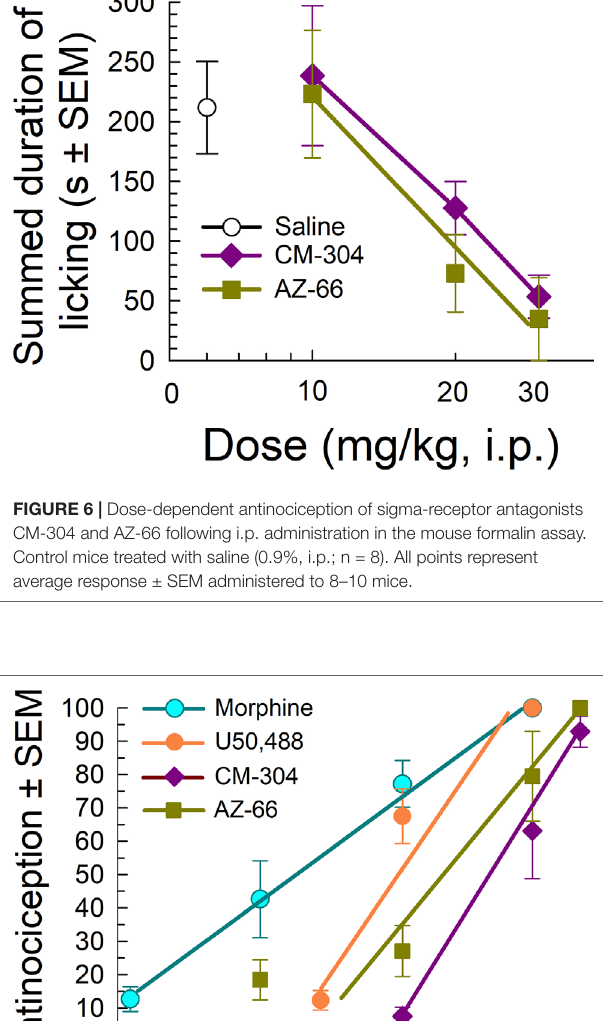
FIGURE 8 | Dose- and time-dependent (A) respiratory depression and (B) spontaneous locomotor effects of morphine (cyan circles) or U50,488 (orange hexagons) evaluated in the CLAMS assay with C57BL6/J mice. * = significantly greater than vehicle effect (dashed line), p < 0.05; two-way ANOVA w/Dunnett’s post hoc test. N = 16–20